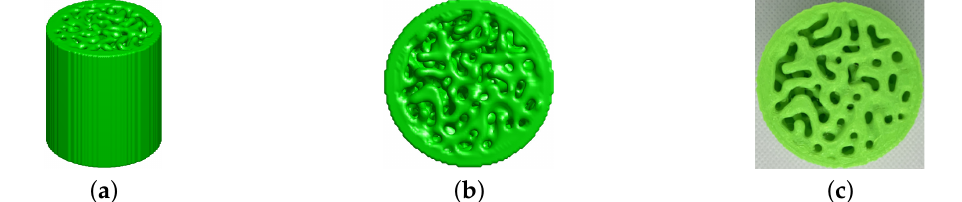
Figure 6. ( a , b ) Zero level isosurfaces of φ with closed cylinder at t = 200 ∆ t , and ( c ) its corresponding 3D printed